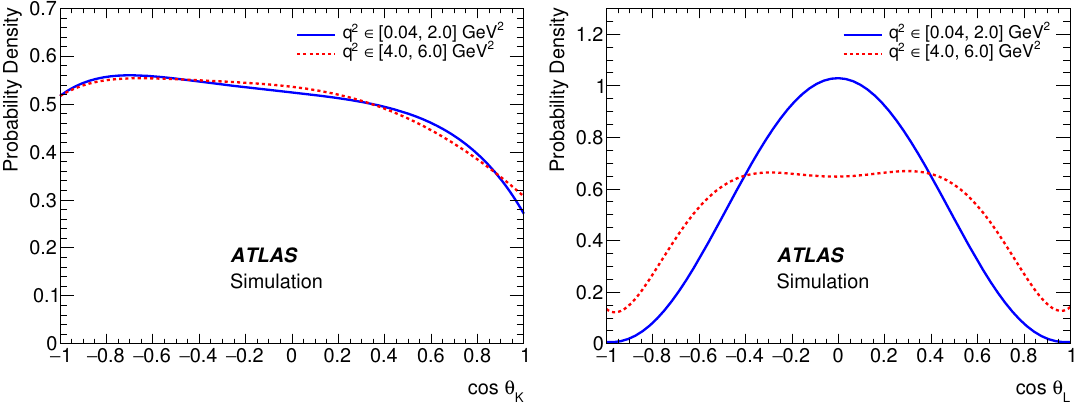
Figure 2 . The acceptance functions for (left) cos (cid:18) [0 : 04 ; 2 : 0] GeV 2 and (dashed) q 2 2 [4 : 0 ; 6 : 0] GeV 2 , that shape the angular decay rate of equa- tion